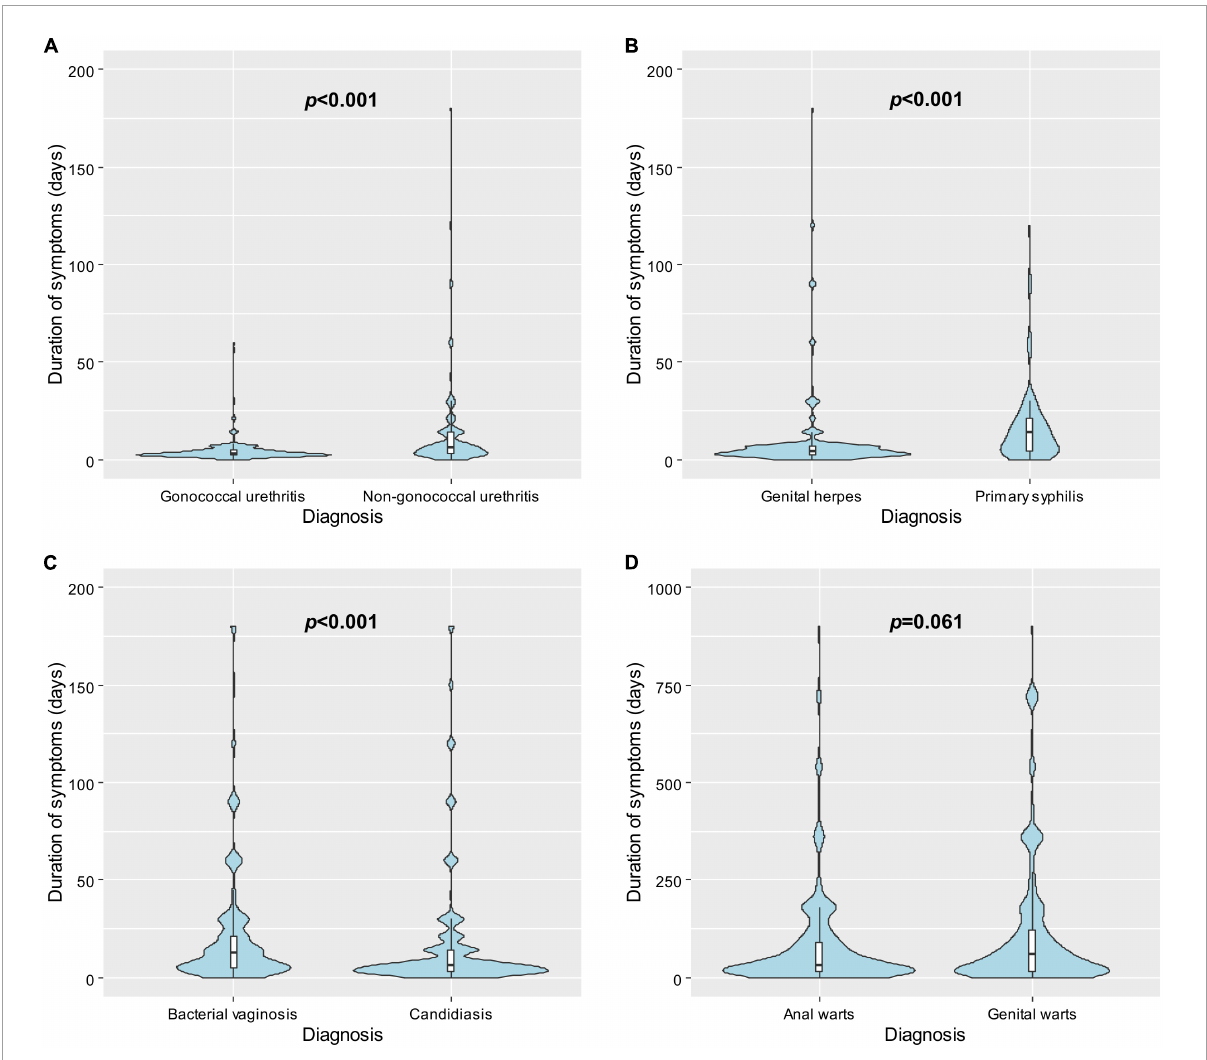
FIGURE2 Violin plots showing the distributions of the time to healthcare seeking following symptom onset in days by diagnosis and box plots showing the observations from the 25th to the 75th percentiles among individuals with (A) gonococcal urethritis vs. non-gonococcal urethritis; (B) genital herpes vs. primary syphilis; (C) bacterial vaginosis vs. candidiasis; and (D) anal warts vs. genital warts. P -values were calculated using Mann–Whitney U